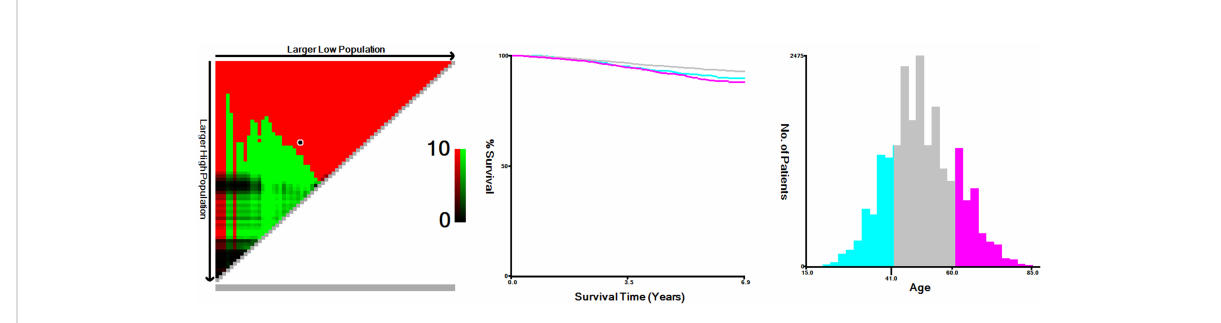
FIGURE 2 Age of patients divided by X-tile software at the best cut point.